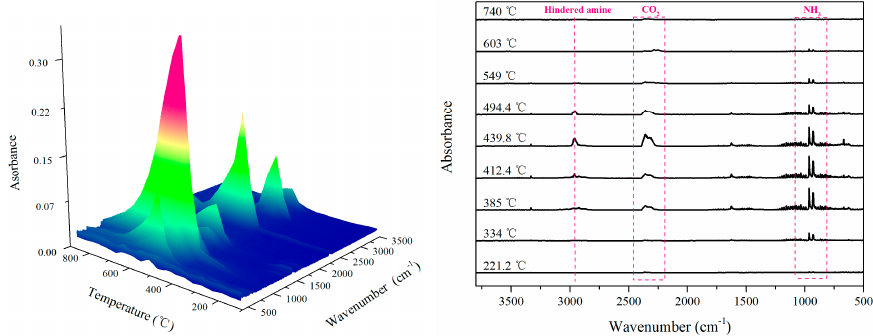
Figure 7. 3D TG-FTIR spectra pyrolysis products for PETAT/APP (weight ratio is 2:1) and corresponding FTIR spectra at different temperature.